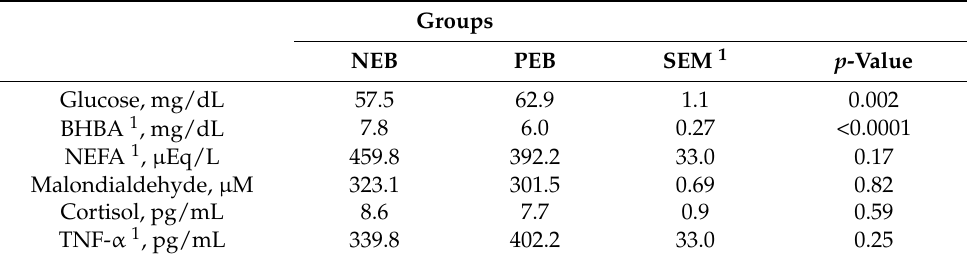
Table 2. Average concentrations of plasma metabolites and stress biomarkers of negative energy balance (NEB) and positive energy balance (PEB) cows during the first 21 d in lactation. Groups